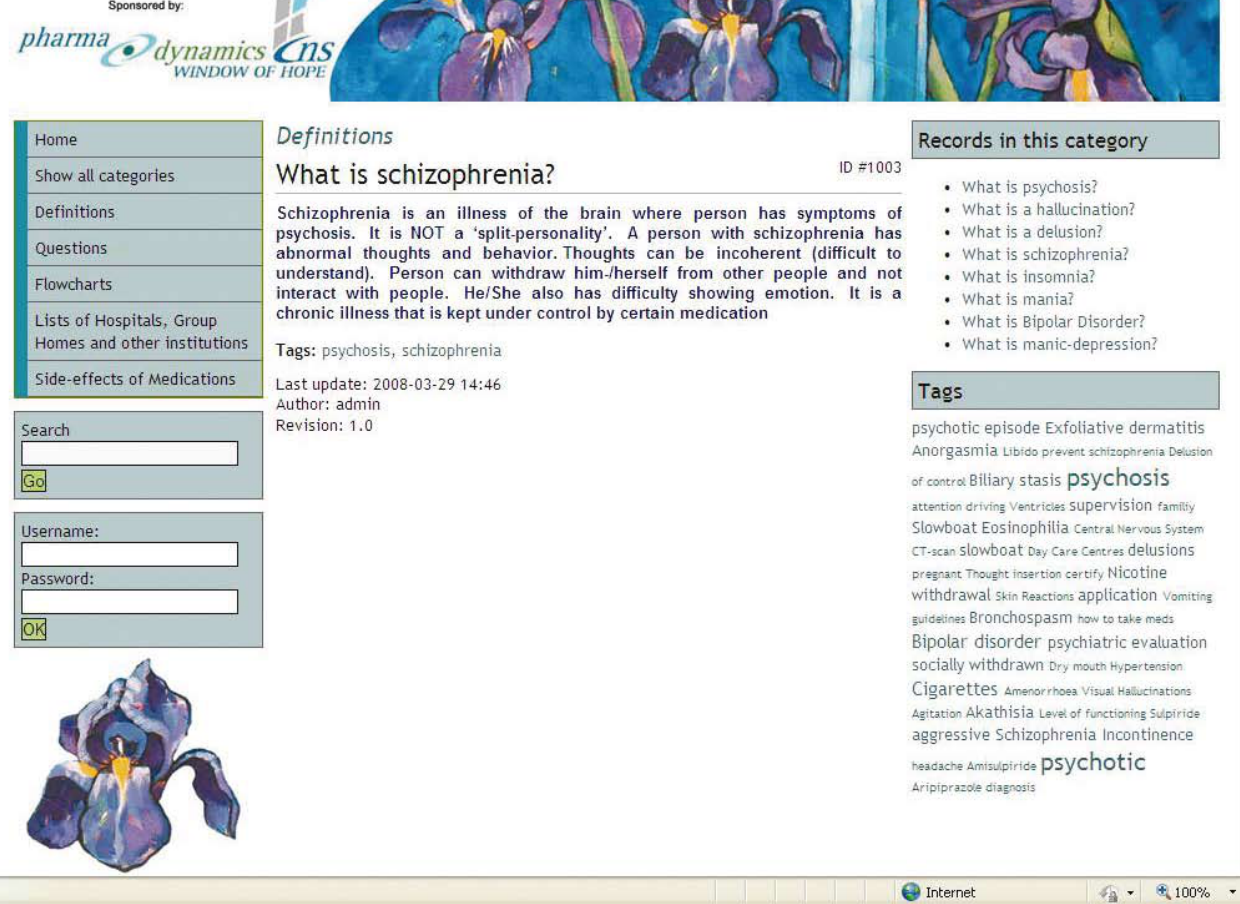
Fig. 3. Example of a FAQ,